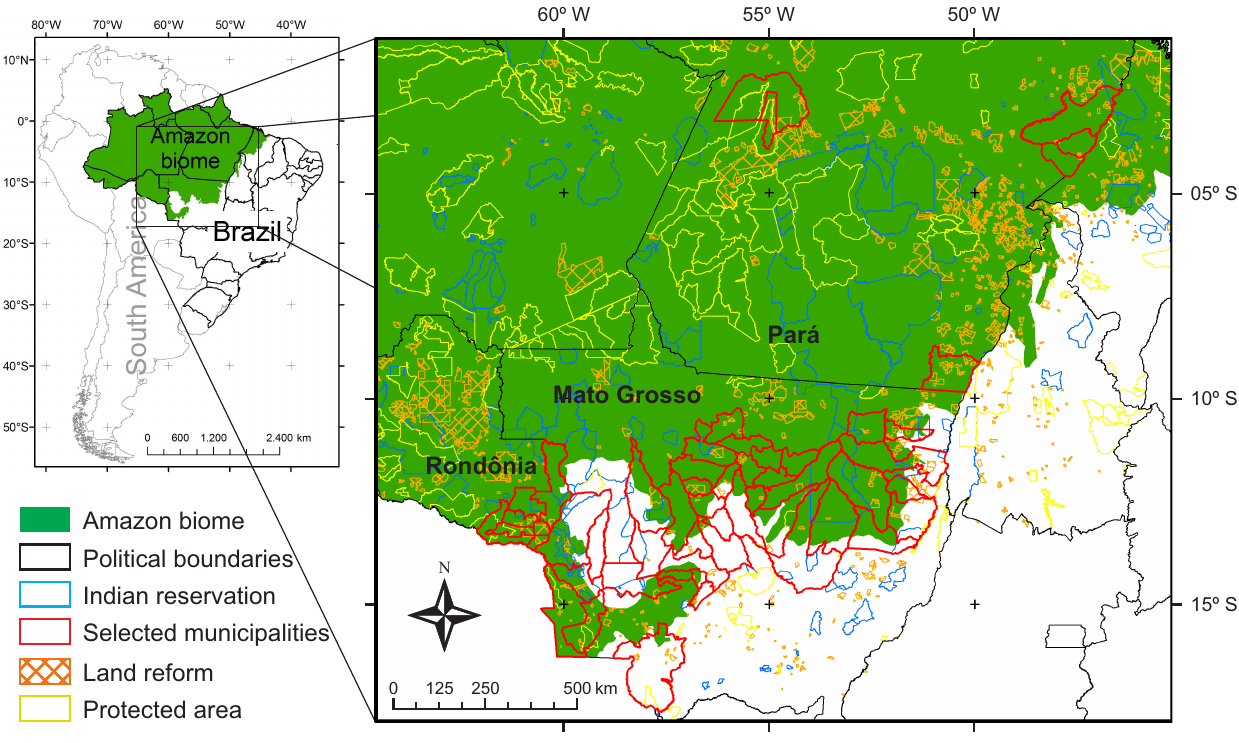
Figure 1. Selected study area based on: Amazon biome; 52 municipalities with more than 5,000 ha soybean; and outside conservation units, indigenous lands and areas of land reform.